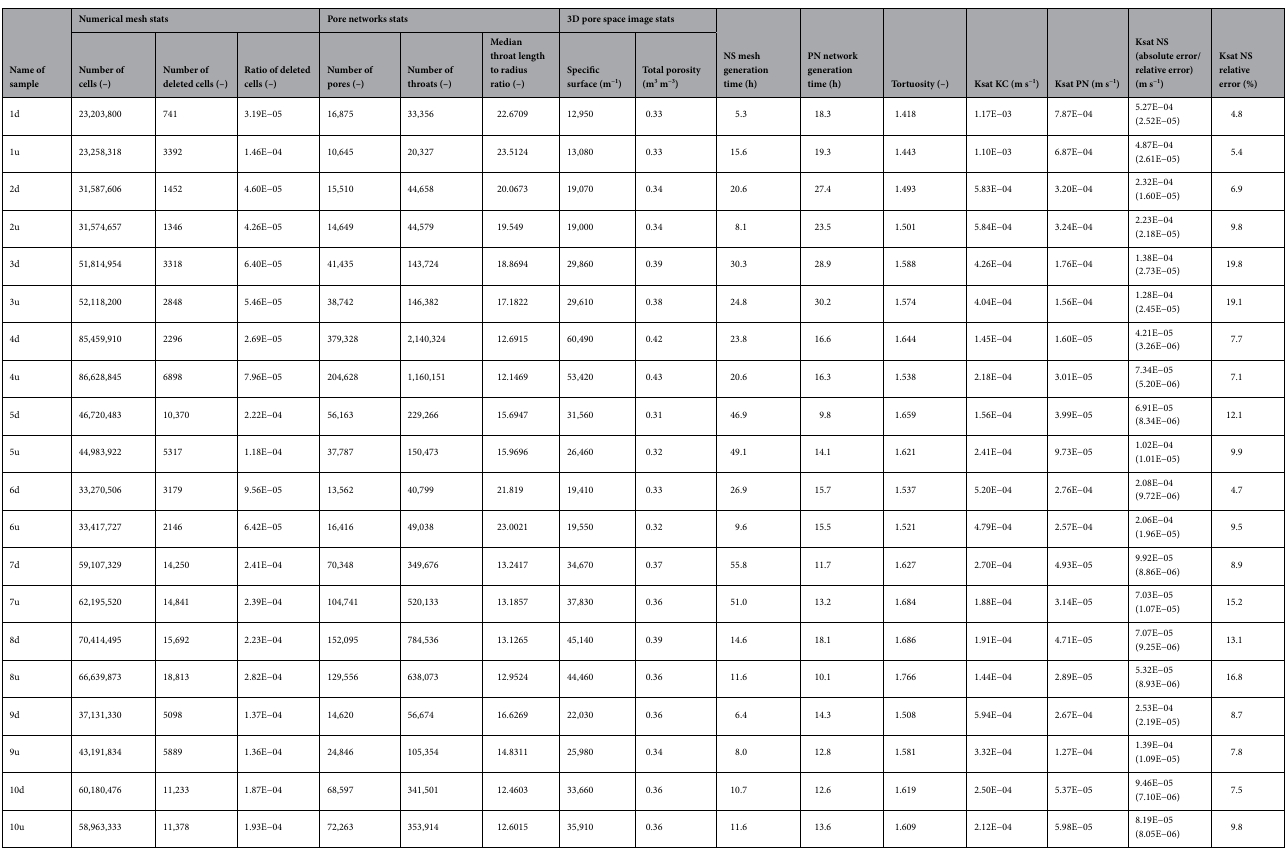
Table 1. Pore space geometry, numerical mesh, and pore network stats of samples.